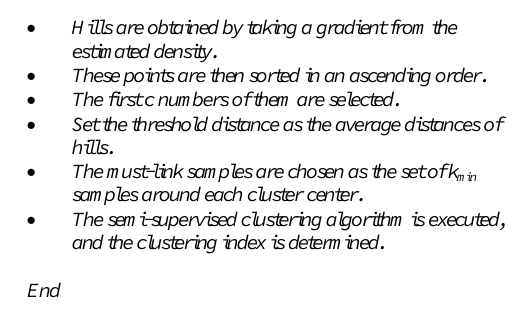
Figure 1. Pseudo-code of proposed algorithm.